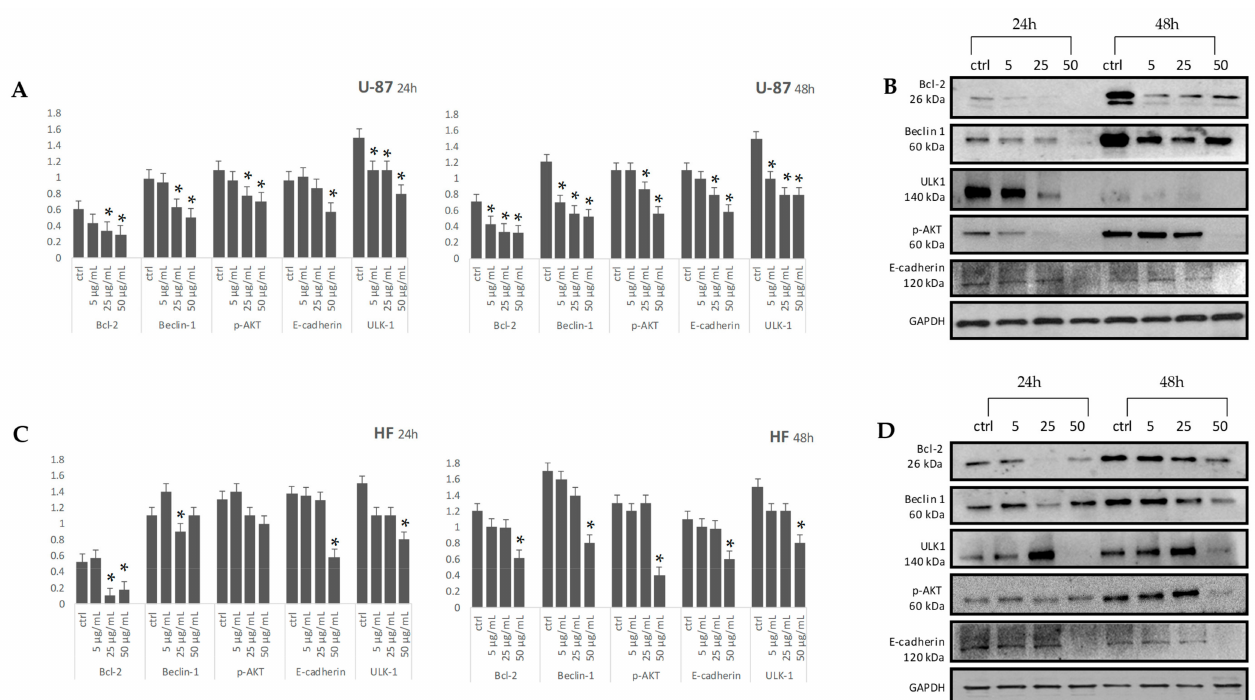
Figure 9. Levels of Bcl-2, Beclin-1, p-AKT, E-cadherin and ULK-1 in U-87 and HF cell types were detected using western blotting with respective antibodies. Graphical representation of pixel quantization of Bcl-2, Beclin-1, p-AKT, E-cadherin, and ULK-1 normalized to GAPDH (panels A , C ). The intensities of signals were expressed as arbitrary units. * p < 0.05 vs. untreated cells (ctrl). Representative western blotting image of Bcl-2, Beclin-1, p-AKT, E-cadherin, ULK-1 and GAPDH are in panels B (U-87 cell type), and D (HF cell